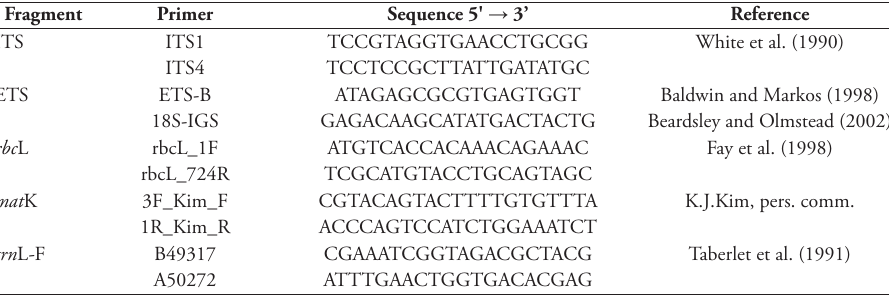
Table 1. List of the primers used in phylogenetic analysis. Fragment